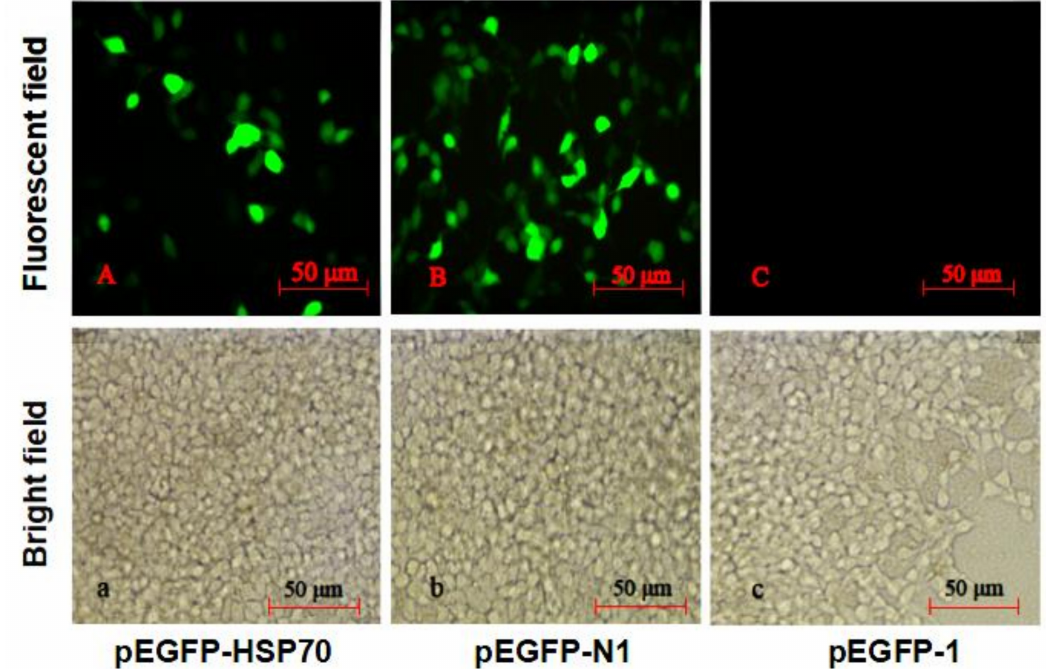
Figure 5. The expression of pEGFP-HSP70 in HEK293FT cells. HEK293FT cells were transfected with pEGFP-HSP70 vector that used the HdHSP70 target promoter ( A ), pEGFP-N1 vector served as a positive control ( B ), and pEGFP-1 vector used as a negative control ( C ). After transfected for 24 h, the green fluorescence (EGFP) can be detected in A and B (target plasmid and positive control), but not in C (negative control) under a fluorescence microscope. Fluorescent fields are shown in ( A , B and C ) and bright fields are observed in ( a , b , and c ) separately. Values are means ± SD of biological replicates ( n = 3). Scale Bars were 50 µ